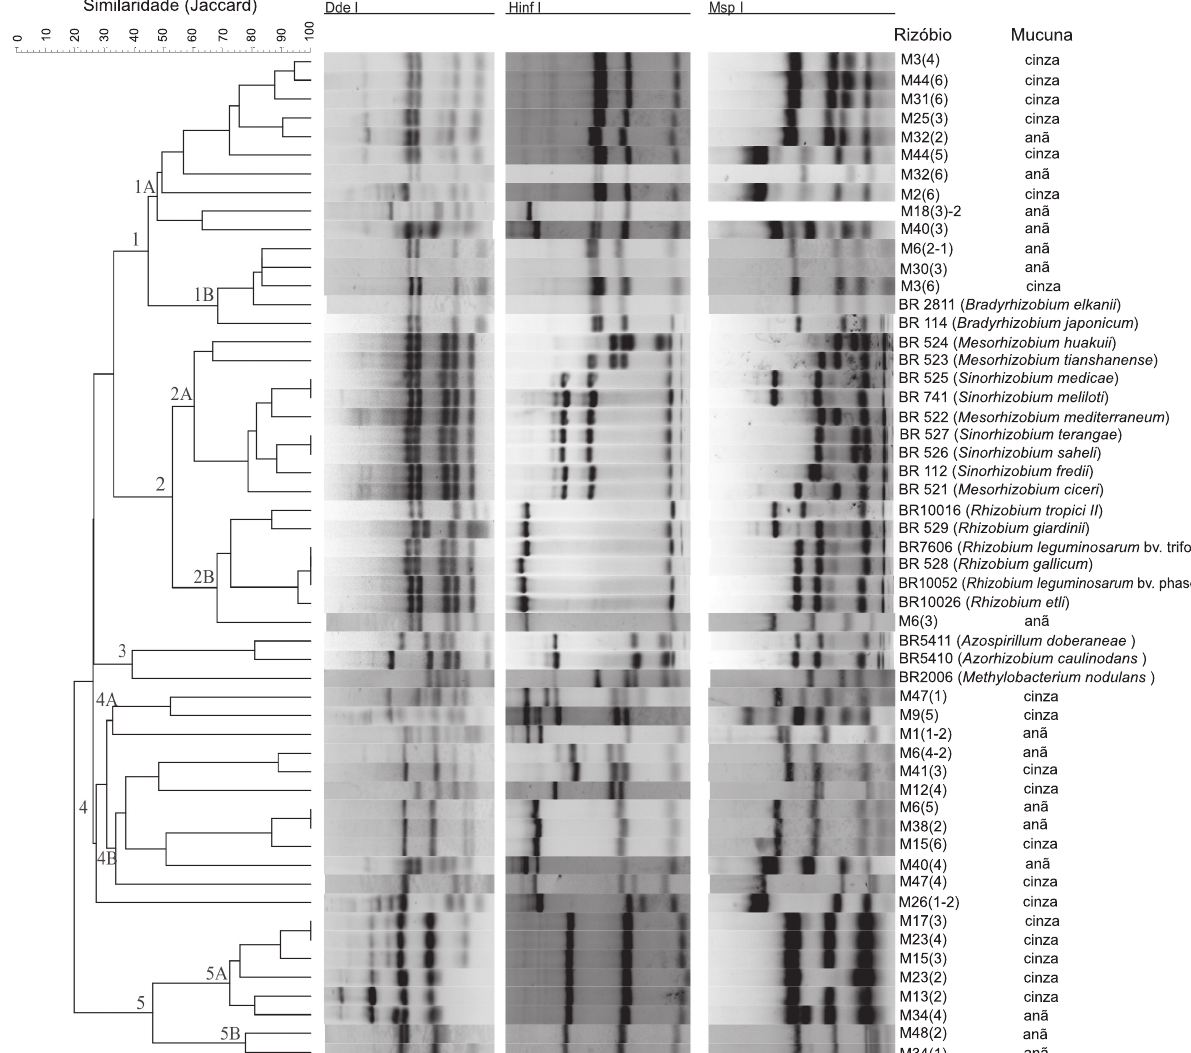
Figura 1. Dendrograma de similaridade de isolados bacterianos de nódulos de mucunas-anã e cinza e 20 estirpes de referência por meio da técnica de arDra-16s rDNa, utilizando as enzimas de restrição Hinf i, Msp i e Dde